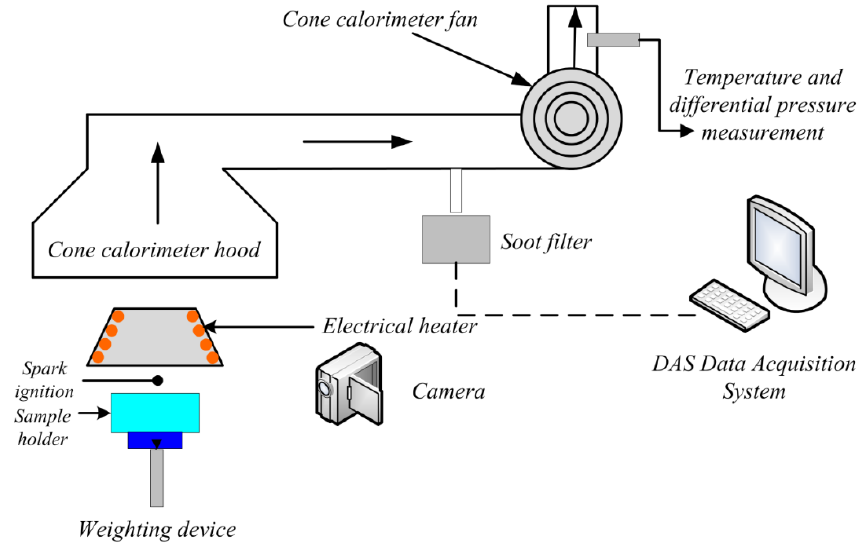
Figure 2. The structure of the cone calorimeter.